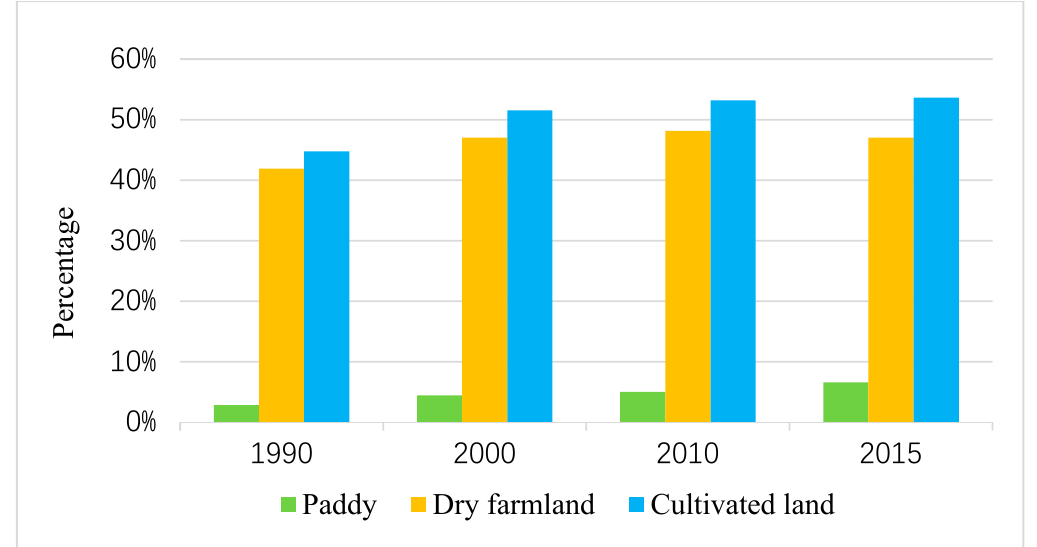
Figure 2. The evolution of the structure of the cultivated land from 1990 to 2015.